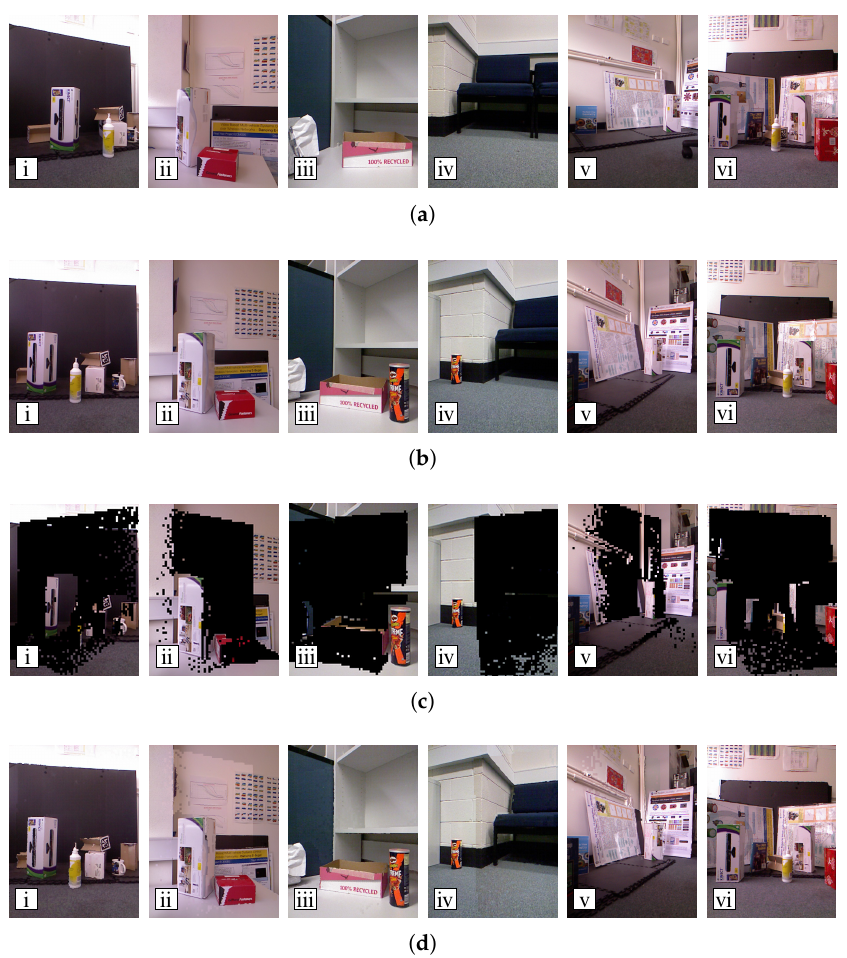
Figure 12. A demonstration of the RPRR framework over six scenes. ( a ) images captured and transmitted to the remote monitoring station by sensor a ; ( b ) images captured by sensor b . Note that these images are not transmitted to the remote monitoring station; ( c ) image blocks transmitted by sensor b (black regions denote the parts of an image that are identified as redundant by our scheme and consequently not transmitted); ( d ) reconstructed images of sensor b ’s point of view. They are produced at the remote monitoring station using the partial images transmitted by sensor b shown in row ( c ), and ideally should be identical to the corresponding images in row ( b